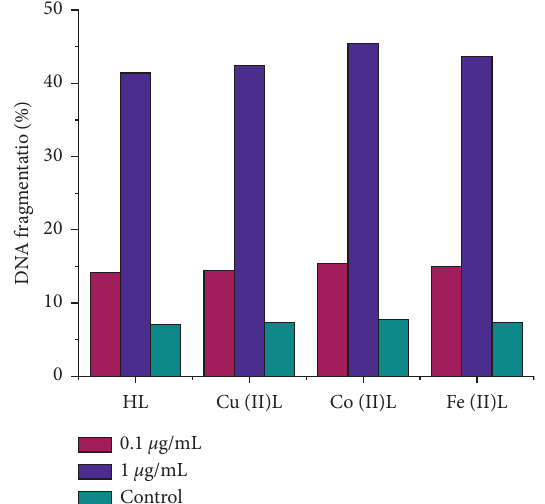
Figure 13: Quantitative estimation of DNA fragmentation % by the diphenylamine assay at various concentrations.